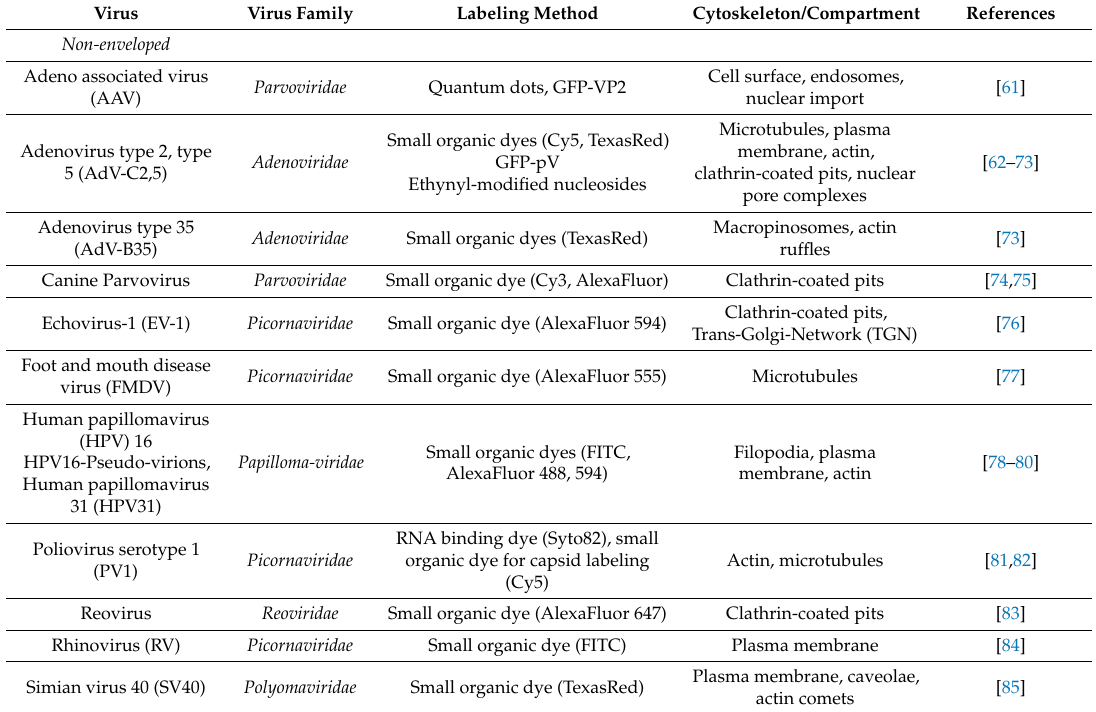
Table 1. Fluorescent animal